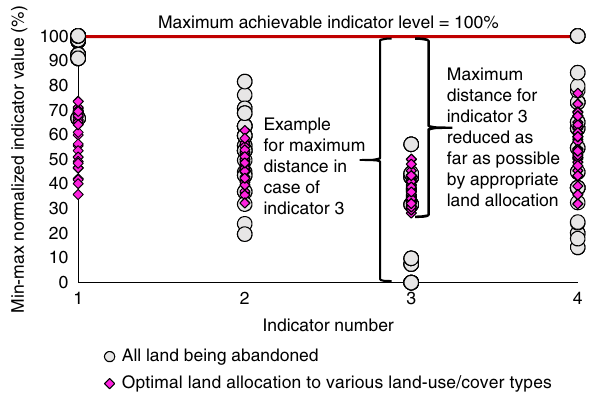
Figure 3 | Schematic description illustrating improvement of achieved minimum levels of indicators. The graph shows the min–max normalized (that is, indexed) achievement levels ( y axis) for four potential indicators ( x axis). The indexed indicators are scaled from zero (least desirable indicator value) to 100% (most desirable value). The four indicators given as examples represent the pH (indicator 1), soil organic carbon (indicator 2), base saturation (indicator 3) and carbon in microbial biomass (indicator 4). Each point represents the indicator achievement level for the considered uncertainty scenarios (2 5 ¼ 32) for each indicator. Results for two land-use allocation scenarios are depicted: grey circles represent the indicator values under the scenario that all of the land is allocated to abandoned land. For indicator number 3, abandoned land would give the least desirable indicator value of zero for some of the uncertainty scenarios. Hence, the maximum distance to the most desirable value is 100%. Pink diamonds represent the indicator achievement levels under the ‘optimized’ scenario, consisting of a mixture of various land-cover types, which buffers against uncertainty. In this scenario, land is allocated to the five land-cover types (four rehabilitation options plus the ‘abandoned’ category) in a way that minimizes the maximum distance to the 100% achievement level. Here landscape-level indicators consist of the sum of the indicators recorded for the individual land-cover types (reported in Table 1), which have been multiplied with the area fraction allocated to the corresponding land-cover